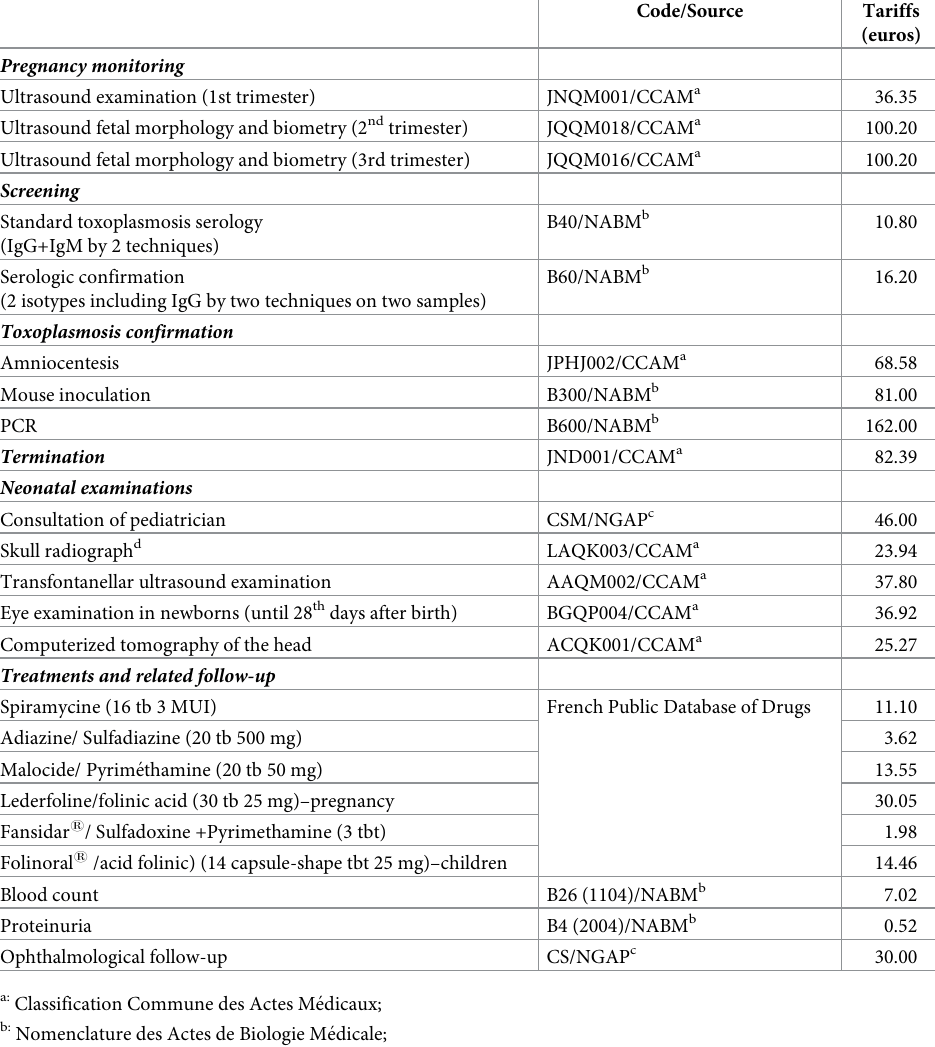
Table 2. Tariffs of examinations and treatments—Toxoscreen